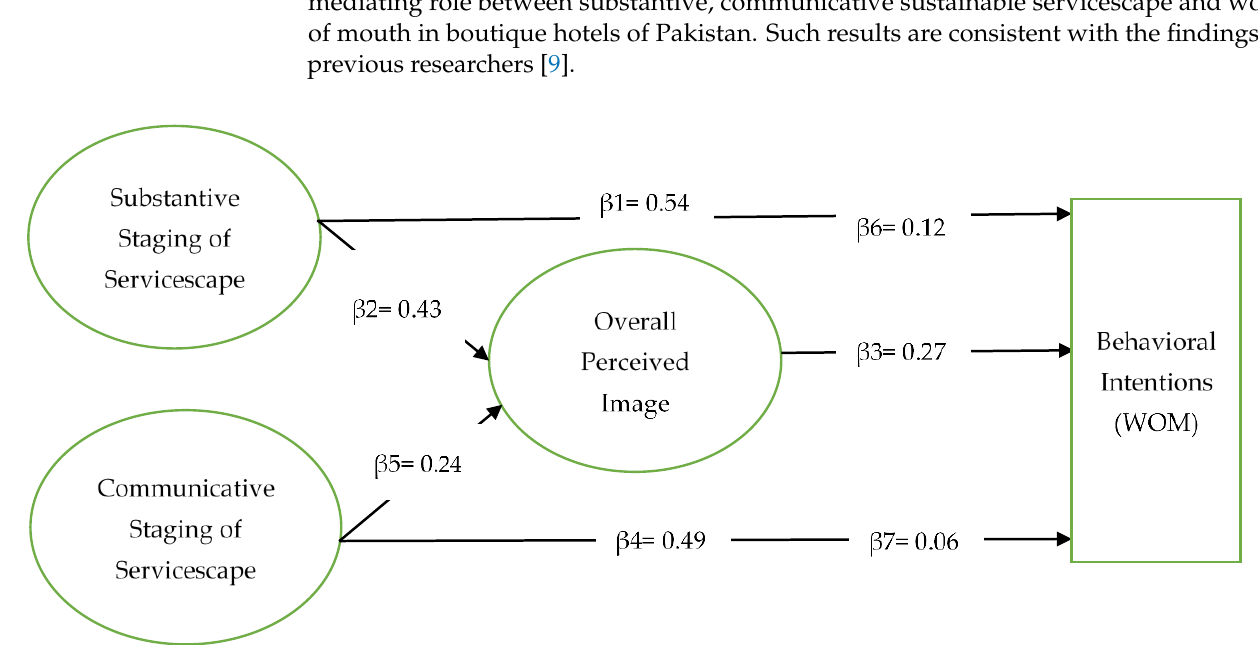
Figure 2. The research models with regression weights and